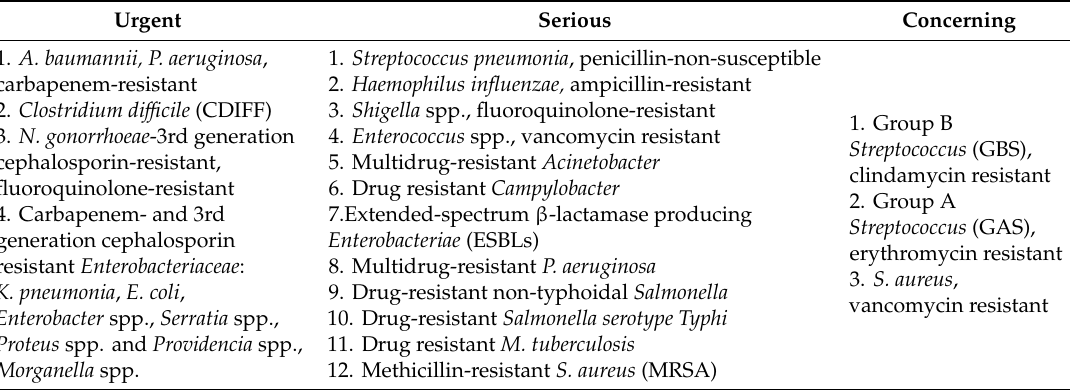
Table 1. Classification of antibiotic resistance threats.